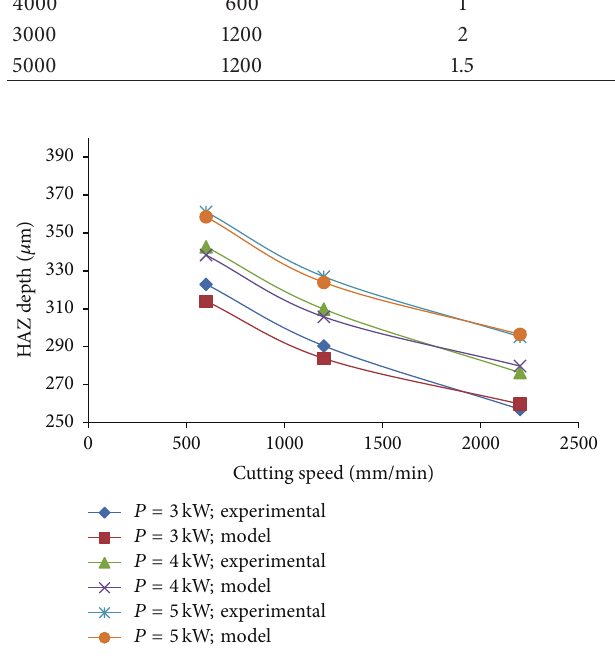
Figure 9: Comparison between experimental and modelled HAZ depth ( 𝐷 = 1 mm).